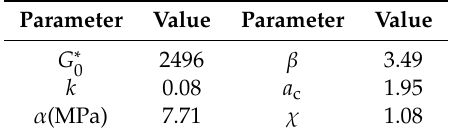
Table 3. Calculation parameters for model prediction.